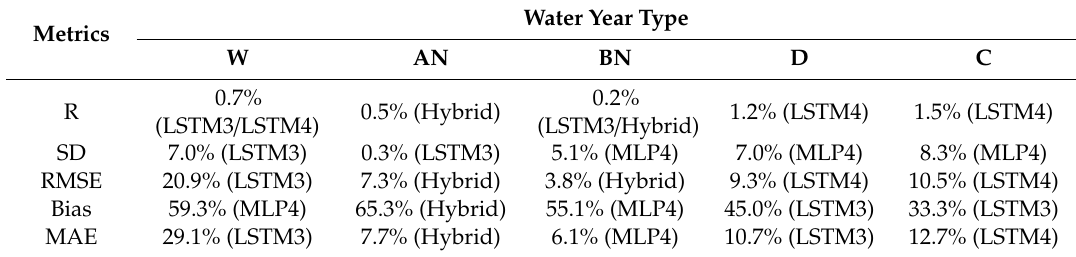
Table 5. Improvements over MBSG metrics in di ff erent water year